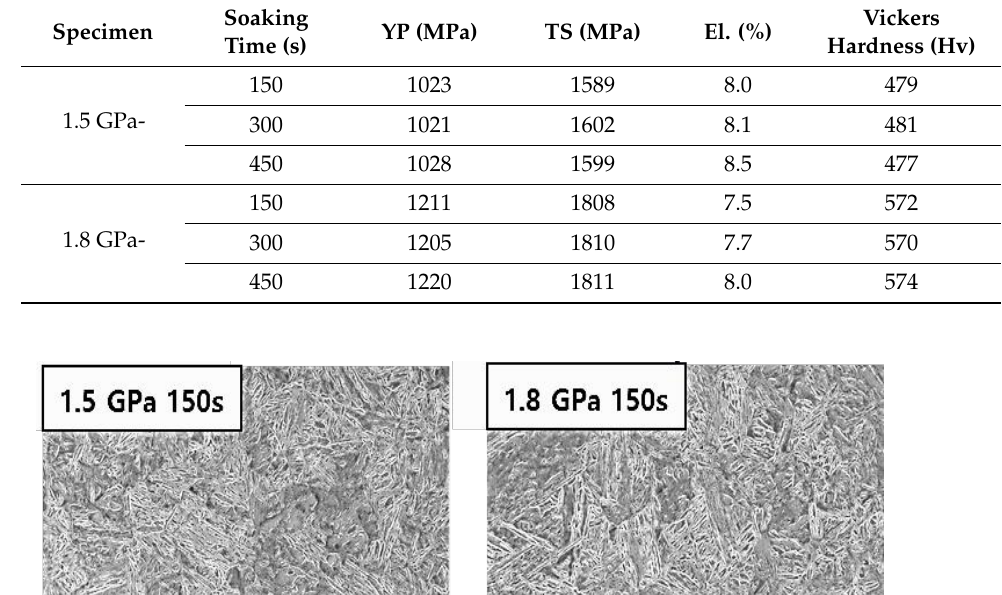
Table 3. The values of parameter from strain–stress curves.